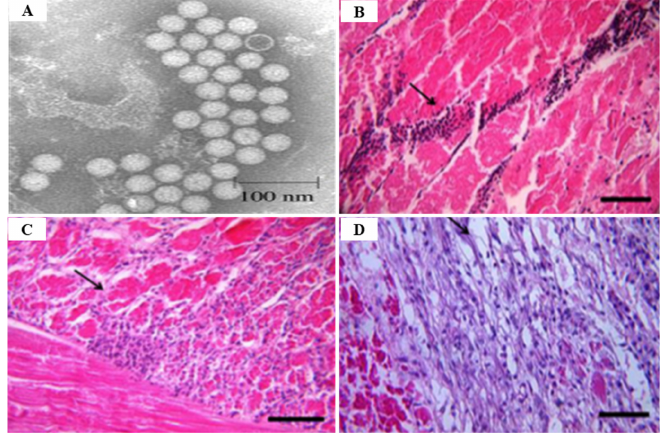
Figure 14. Electron microscopy and histological changes in shrimp with infectious myonecrosis virus (IMNV). ( A ) TEM of a purified preparation of IMNV from naturally infected Penaeus vannamei from Brazil. Photomicrographs of tissue sections from P. vannamei examined for IMNV lesions ( B – D ) (Scale bar = 50 µm); ( B ) Focal hemocytic infiltration in muscle tissue; ( C ) Muscle coagulation necrosis accompanied by infiltration of hemocytes; ( D ) Muscle liquefactive necrosis and fibrosis.